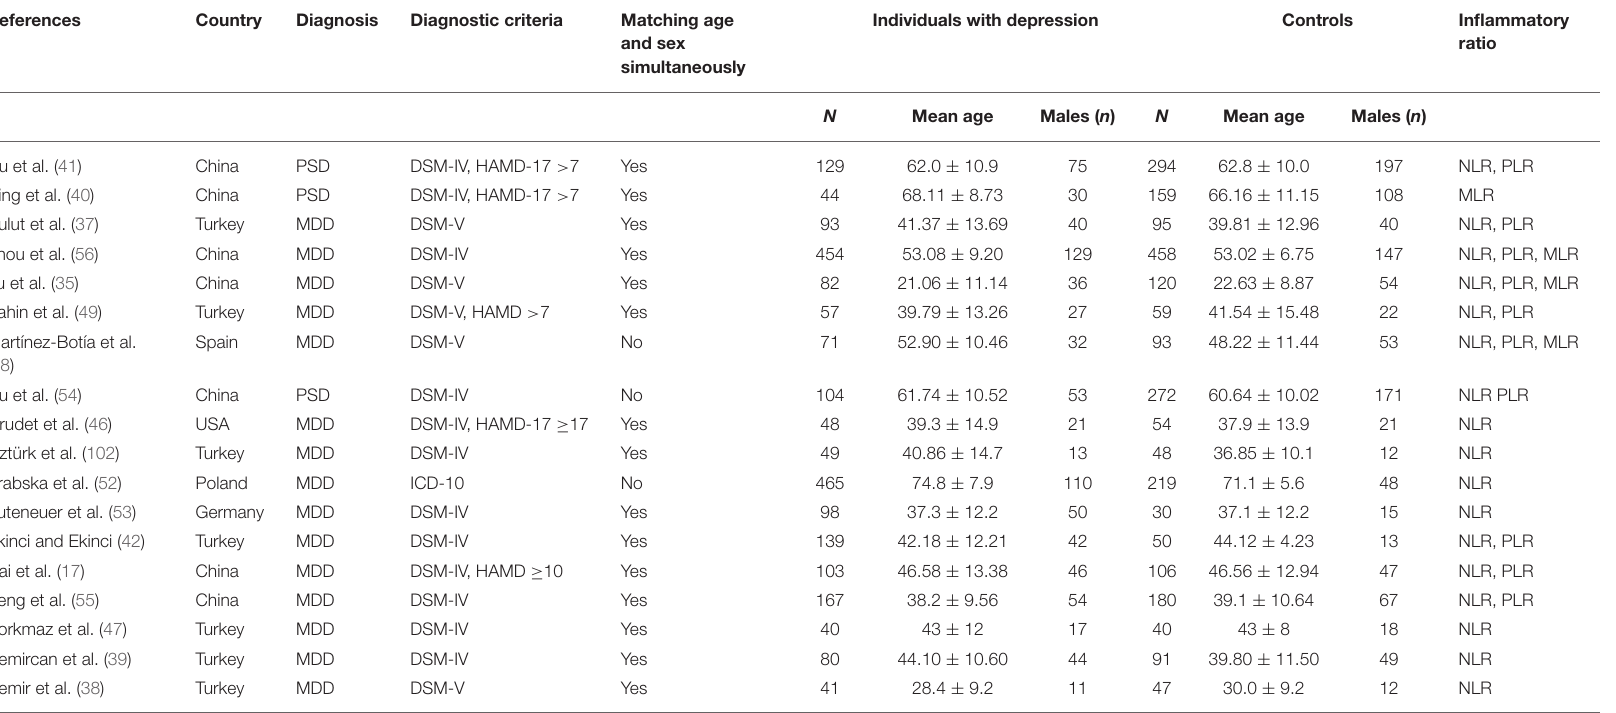
TABLE 1 | Main characteristics of studies included in the